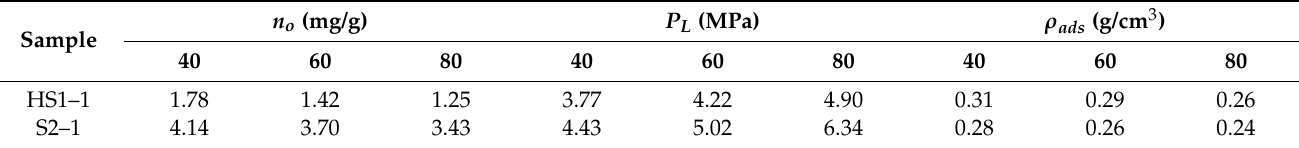
Table 4. Fitted parameters of the Langmuir-based excess adsorption model.